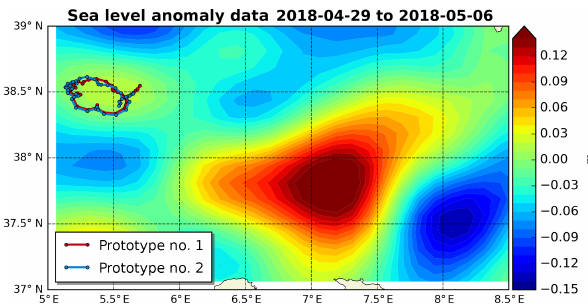
Figure 12. Mean sea level anomaly map with the two SVP-BRST prototypes’ tracks overlaid (prototype no. 1 in red; prototype no. 2 in blue) for the time period 29 May to 13 June 2018.